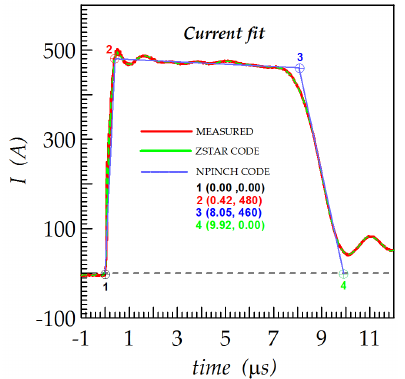
Figure 2. Measured current passing through the tube (orange line), interpolated current used as input for the ZSTAR code (green line) and the current fitted by straight lines connecting points 1,2,3,4 for